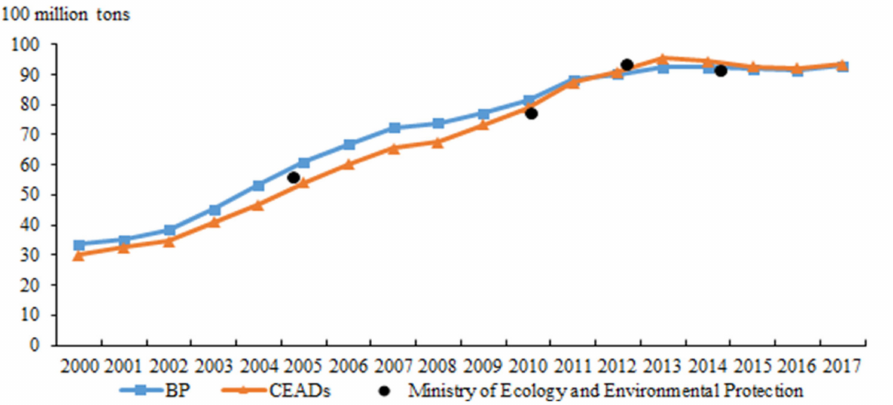
Figure 3. Comparison of China’s carbon emission data in various